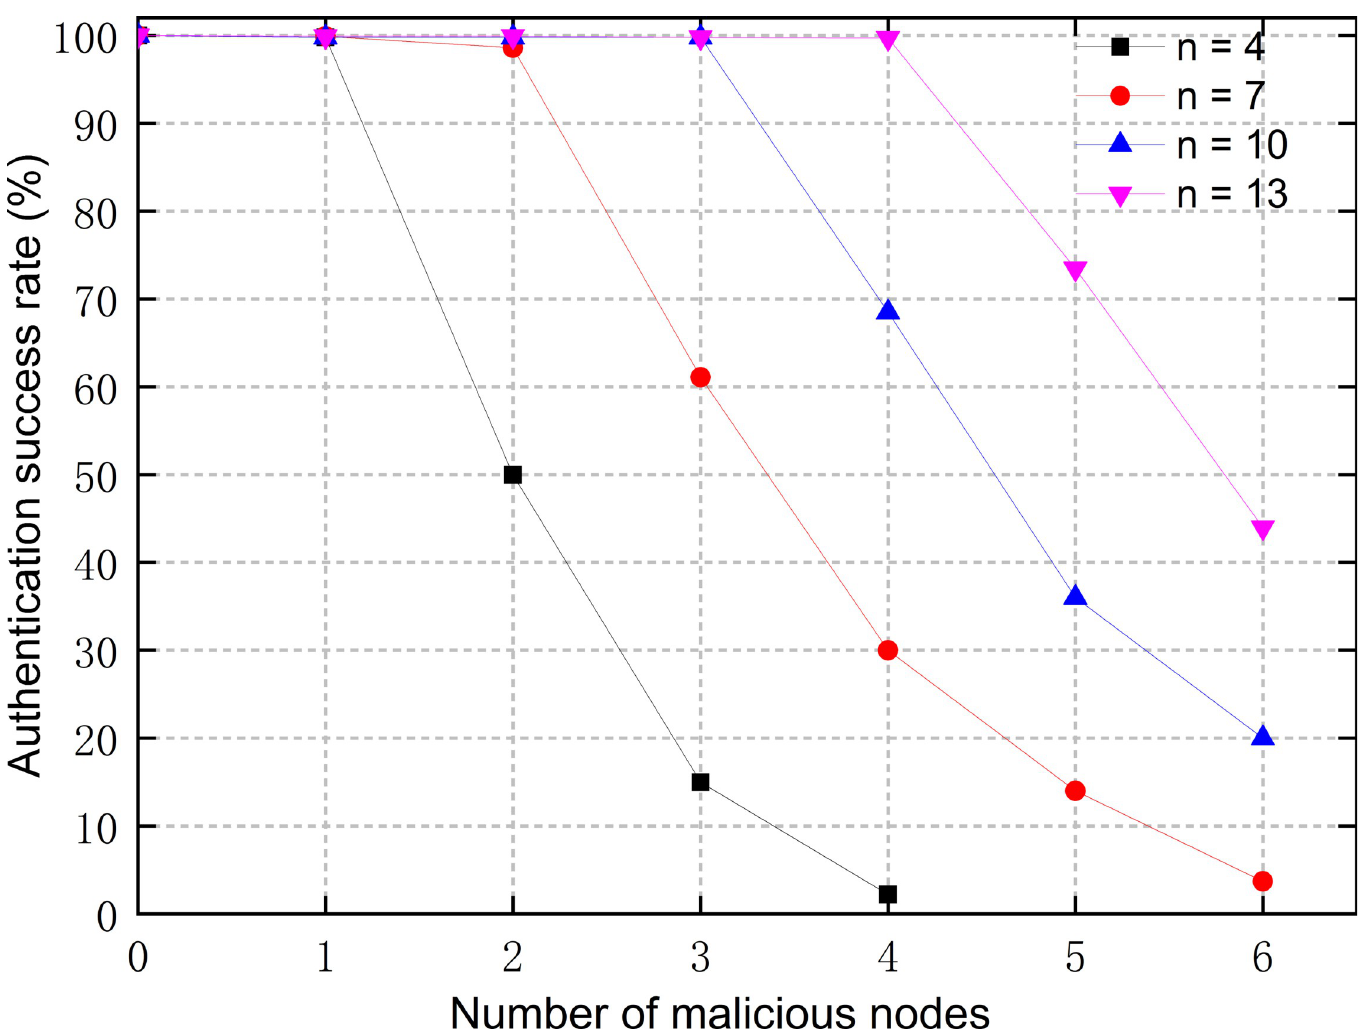
Fig 13. Authentication success rate at different numbers of malicious nodes under scenario 2.